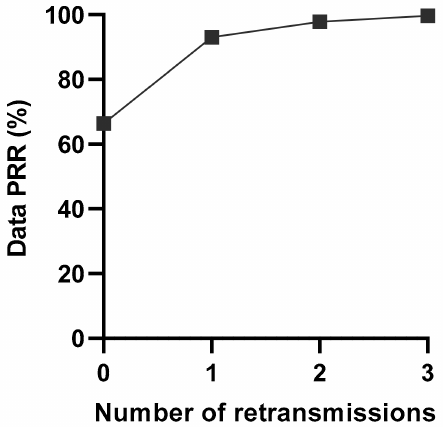
Figure 5. Relationship between the number of retransmissions and the packet reception